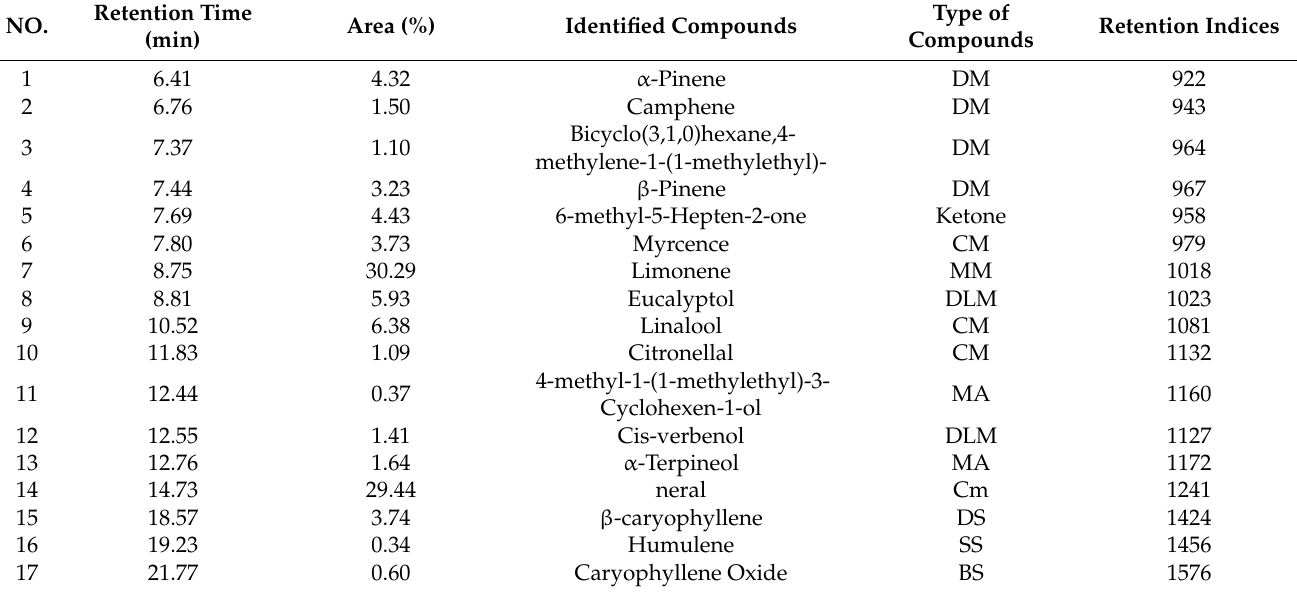
Table 1. The chemical composition of the L. pungens essential